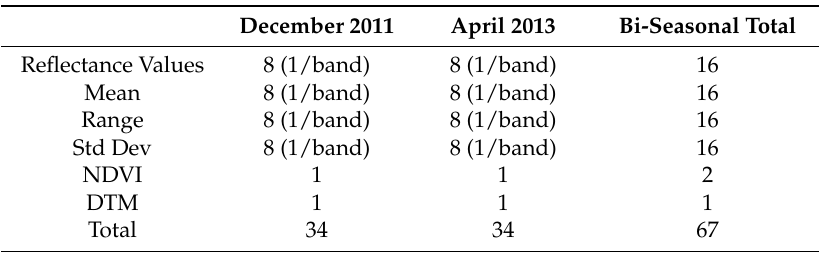
Table 1. Features used in single- and bi-seasonal classifier